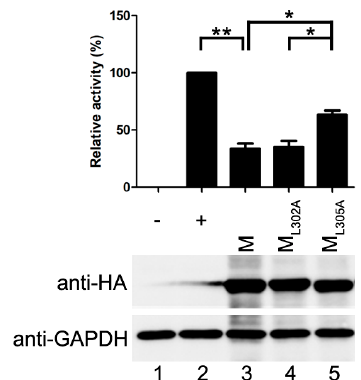
Figure 3. The inhibitory activity of M is independent of its VLP release. vTF7-3-infected HeLa cells were transfected with plasmids encoding N, P, L, minigenome, renilla luciferase and M or M mutants. Relative luciferase activity was measured and the expression of M was detected via Western blot as described for Figure 1C.Values are means ± SD from three experiments. Student’s t test: * p < 0.05, ** p < 0.01.“+,-“means with or without transfecting P plasmid.